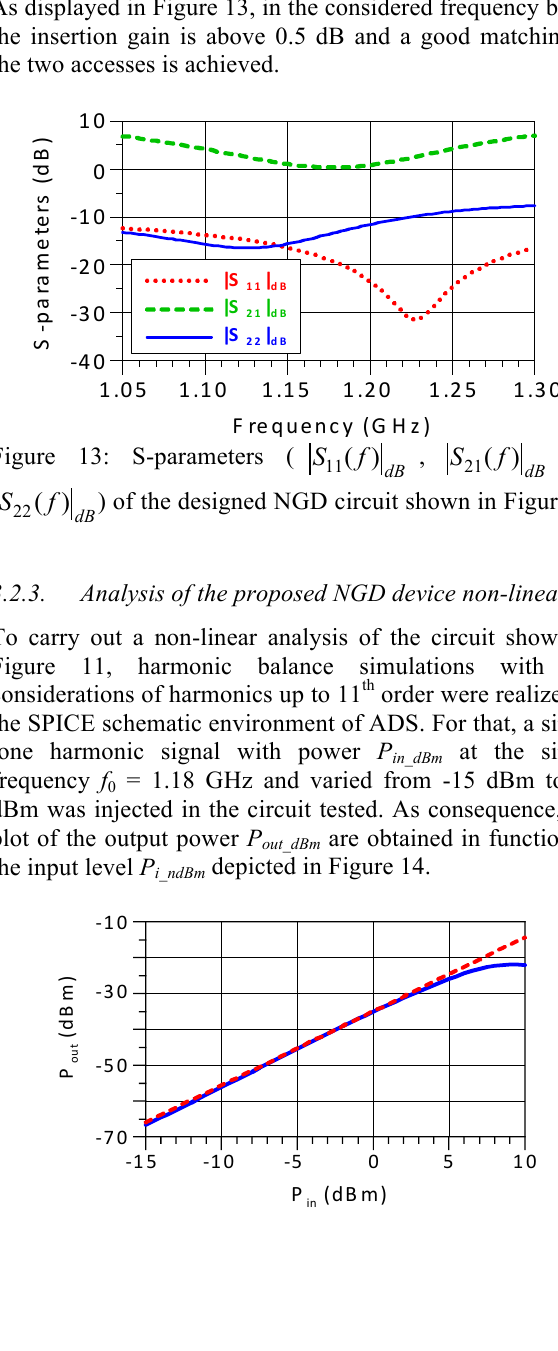
Figure 15: Third order intermodulation products IMD device shown in Figure